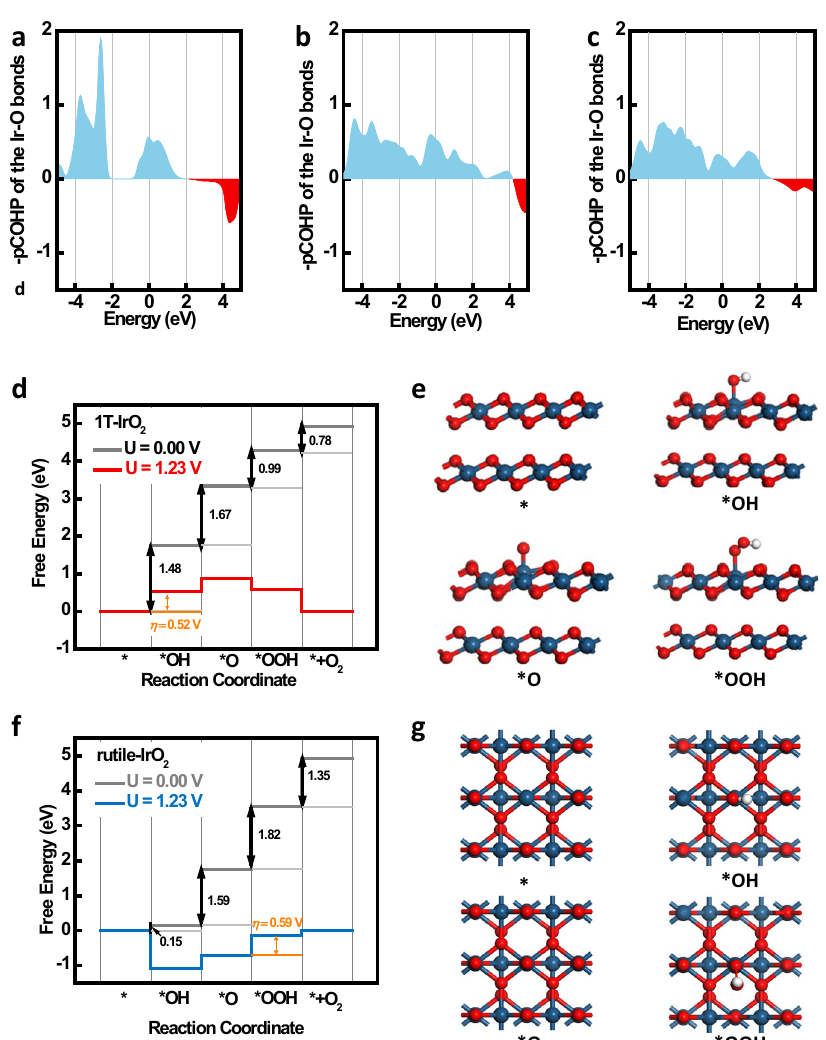
Fig. 5 OER mechanism of 1T-IrO 2 . The pCOHP plots of a the Ir – O bond in 1T-IrO 2 , b the shorter Ir – O bond in rutile-IrO 2 , and c the longer Ir – O bond in the rutile-IrO 2 . The energies have been aligned to the highest occupied states. The blue and red contours represent the bonding and antibonding contributions in Ir – O interactions, respectively. The thermal stability of rutile phase should be better than the 1 T-phase, indicating that 1 T-phase is a metastable phase. d, e The free energy pro fi le of OER over the 1T-IrO 2 . f, g The free energy pro fi le of OER over rutile-IrO 2 (110) surface. The Ir, O, and H atoms are represented with the blue, red, and white circles,